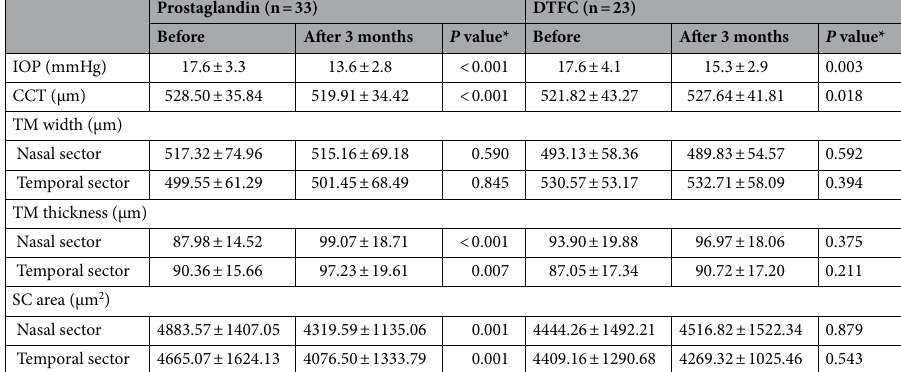
Table 2. Comparison of the TM Width, TM thickness, and SC Area Before and After Topical Medication Usage. *Wilcoxon signed-rank test. TM, trabecular meshwork; SC, Schlemm’s canal; DTFC, dorzolamide/ timolol fixed combination; IOP, intraocular pressure; CCT, central corneal thickness.